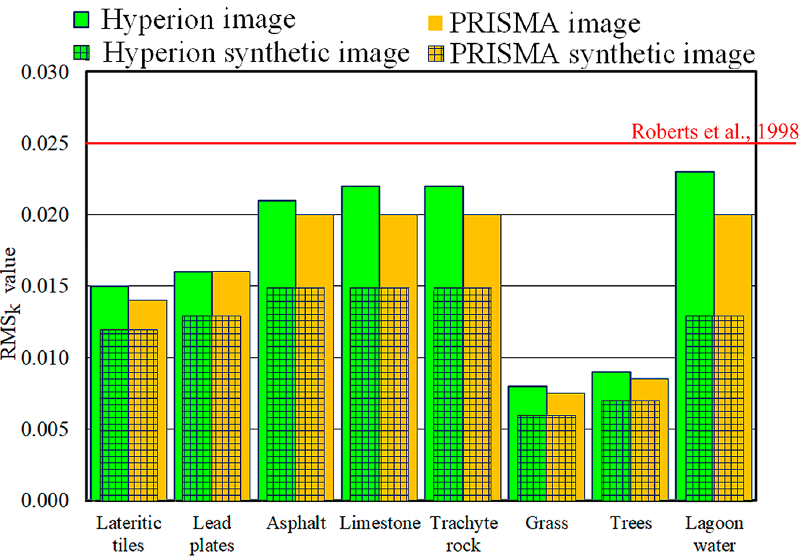
Figure 7. RMS k values obtained from real and synthetic (square pattern) images of Hyperion and PRISMA sensors . PRISMA sensors [68].